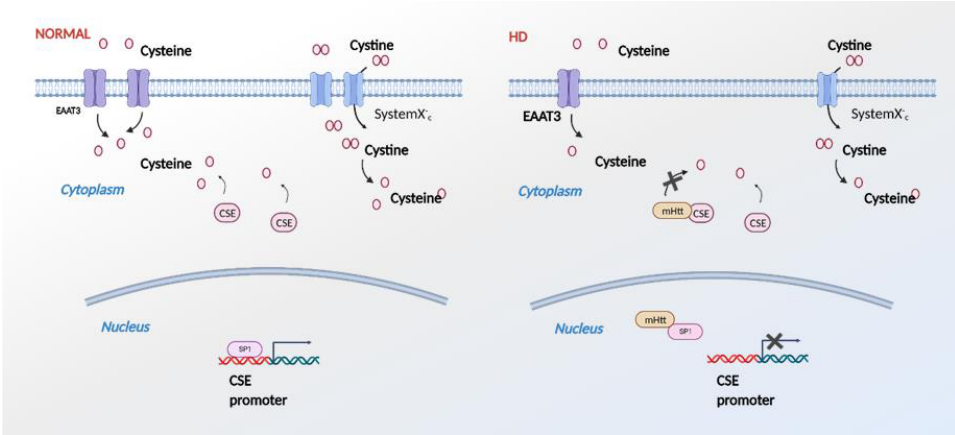
Figure 5. Effects of mutant huntingtin (mHtt) on cysteine metabolism. In HD (right panel), mHtt binds specificity protein 1 (SP1) and inhibits transcription of CSE. mHtt also impairs import of cystine and cysteine by the system Xc - and excitatory amino acid transporter 3 (EAAC1/EAAT3), creating an overall cysteine deficit. In addition to these effects, mHtt binds directly to CSE and inhibits its catalytic activity.